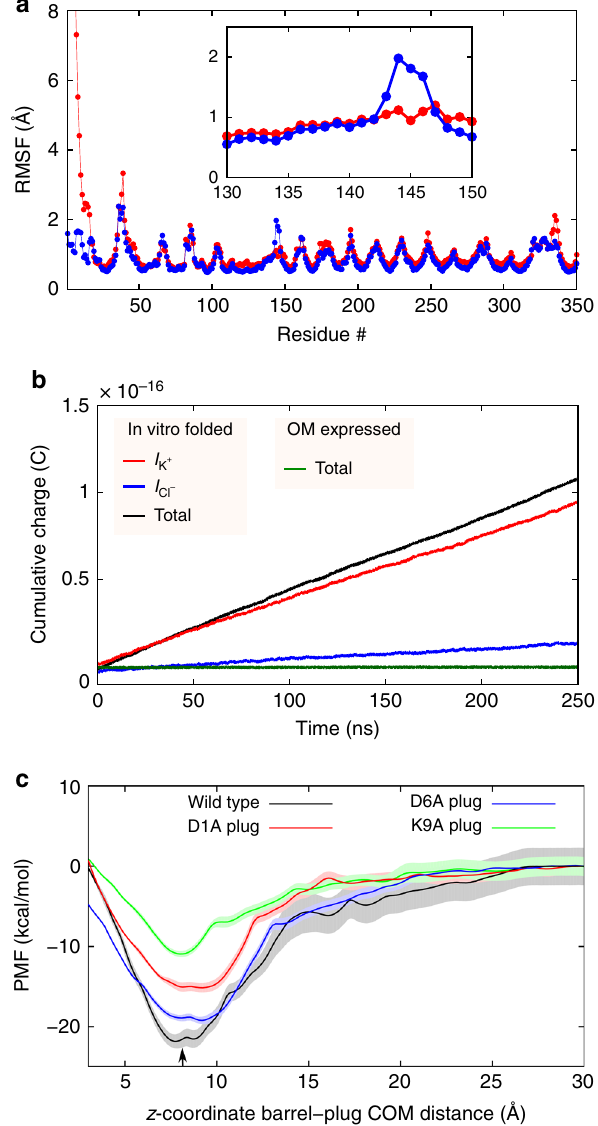
Fig. 3 Behavior of the pore plug in MD simulations. a Average C α RMSF of the protein dynamics in vitro-folded (red) and OM-expressed (blue) Vh ChiP. In addition to the differences for the fi rst 14 residues, a difference in the RMSF for residues 143 – 146 in loop L3 can be clearly observed. b Cumulative total charge as a function of time for a 1 M KCl solution at 200 mV. In addition, the cumulative charges for K + and Cl − ions separately are shown as well. The data was averaged over the three simulations and the slopes of these curves yield the respective currents. c Free-energy surfaces of unbinding of the N-terminus in wild type and mutant channels. The shaded areas indicate the respective error estimates. The arrow represents the position of the N-terminal plug in the crystal structure of OM-expressed Vh